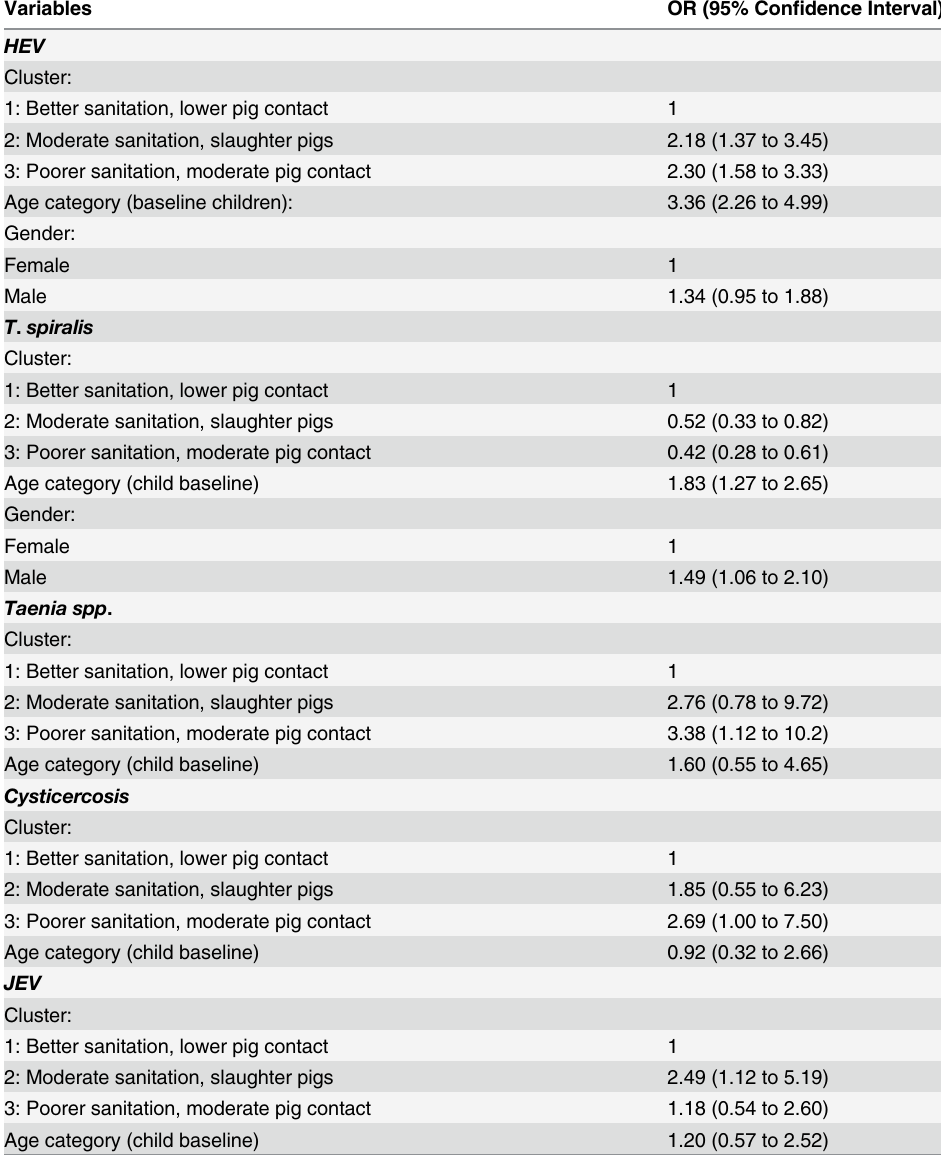
Table 3. Random-effects logistic regression analysis for association between cluster membership and testing seropositive for pig zoonoses.